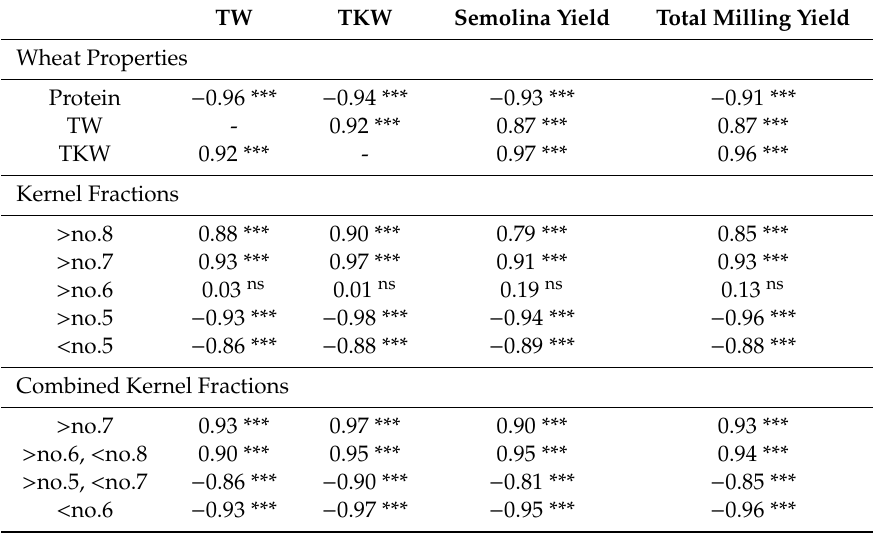
Combined Kernel Fractions >